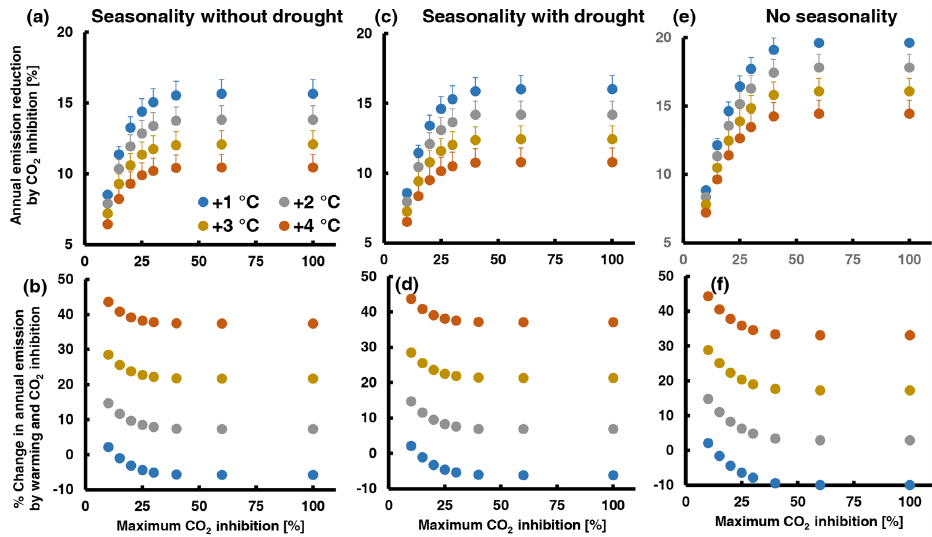
Figure 5. Assessment of the potential effect of high CO 2 inhibition on total annual MT emission from QI leaves under a future warmer climate with a doubled atmospheric [CO 2 ] combining different scenarios of maximum CO 2 inhibition ( x axes), warming (color of dots) and seasonality of the emission factor: (a, b) EF seasonality without summer drought; (c, d) EF seasonality with summer drought; (e, f) no seasonality (constant EF). The lower graphs (b, d, e) show the percentage change in annual emission with respect to today’s values ((future annual E + T + CO – today annual E ) × today’s annual E − 1 × 100) and the upper graphs (a, c, d) the percentage reduction in the future annual 2 × 100). The simulations were run with temperature and PPFD emissions by CO 2 inhibition ((annual E + T – annual E + T + CO ) × annual E − 1 + T 2 data of the years 2019, 2020 and 2021. Data points and error bars (not visible in b , d , f ) are means and standard errors of n = 3 years. A detailed explanation of the simulations and additional illustrations of the results are given in Supplement 3. The assumed seasonal variations in the emission factor are shown in Fig.